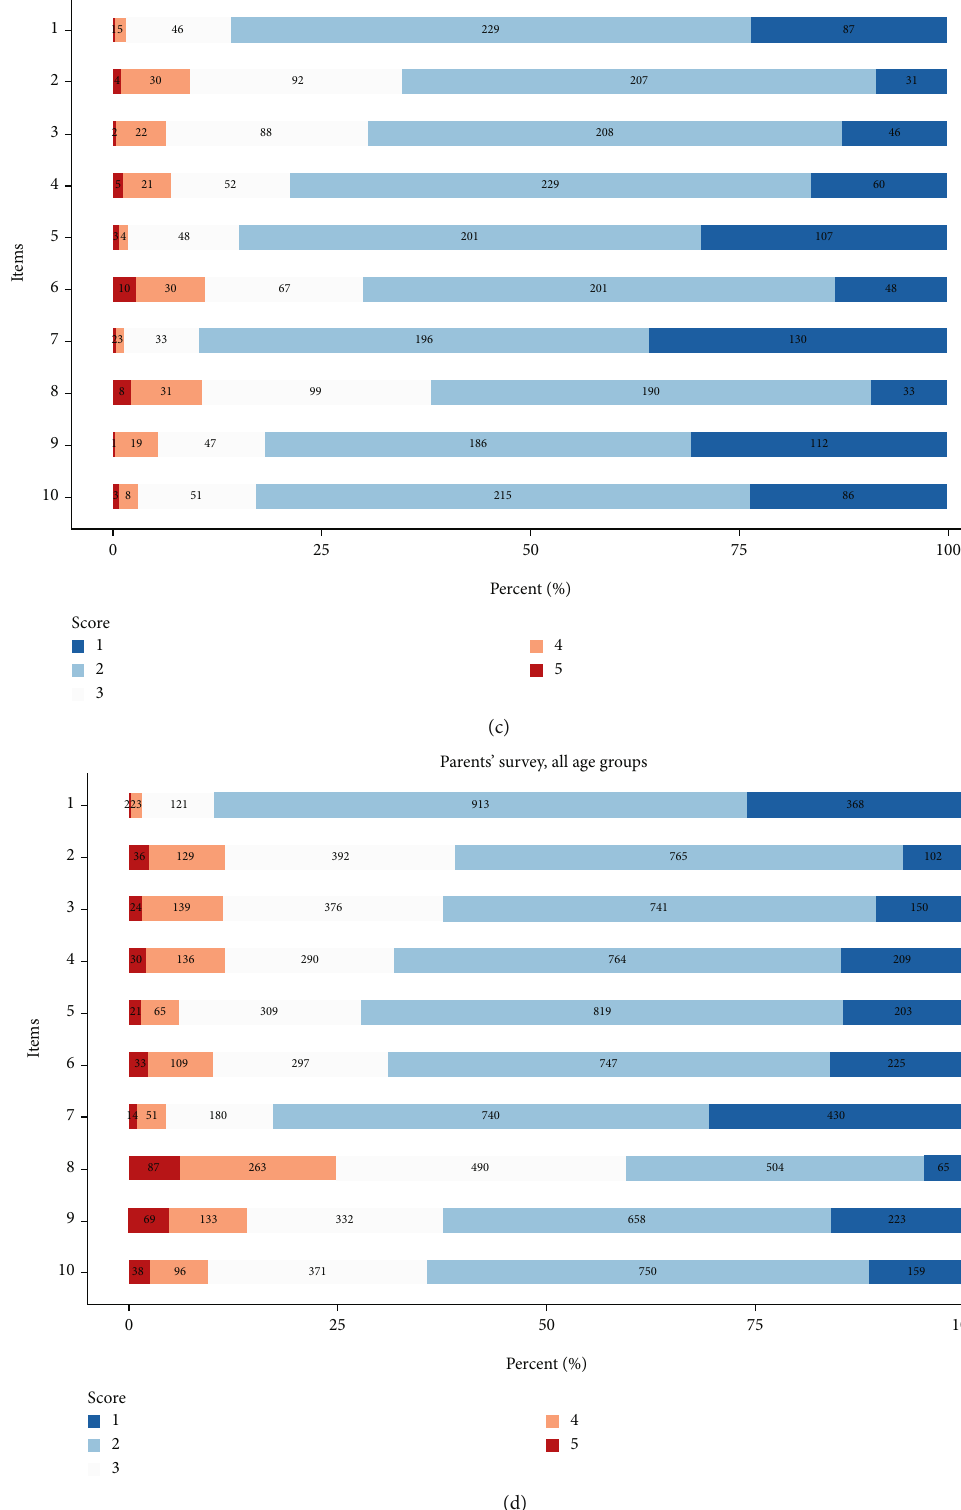
Figure 2: Stacked box plot with responses to items 1 – 10 for (a) children aged 10 – 17 years ( N = 1,019 ), (b) parents of children aged 10 – 17 years ( N = 1,070 ), (c) parents of children under 10 years ( N = 371 ), and (d) all parents ( N = 1,441 ). Valid N is marked in the bars. Blue re fl ects a higher quality of